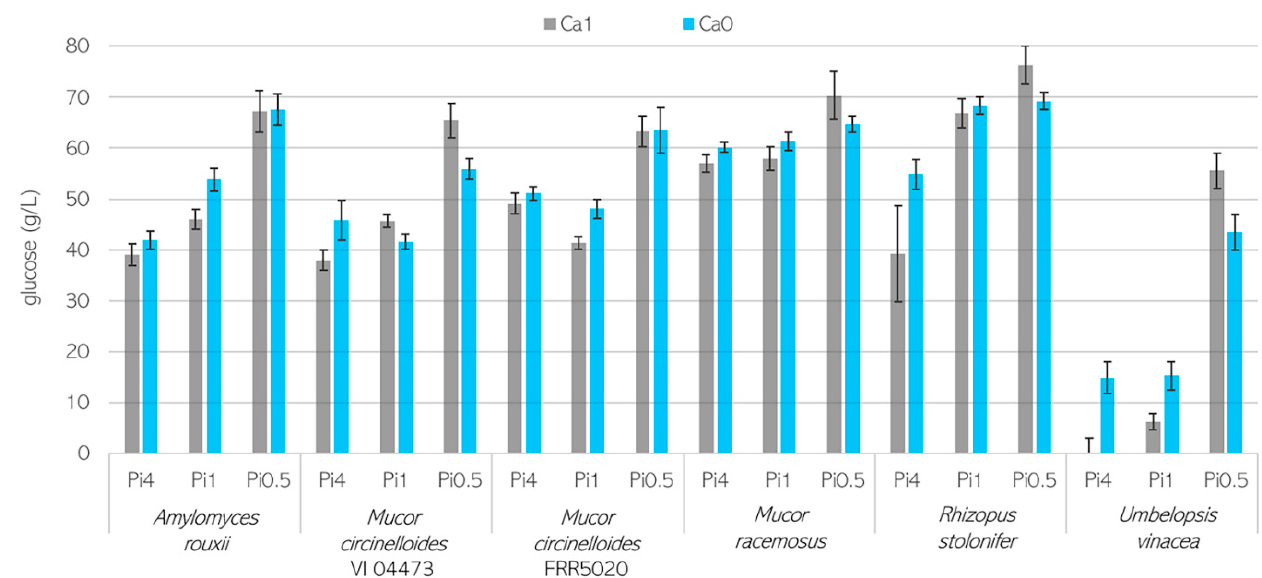
Figure 2. The residual glucose in g/L in the culture supernatants. The glucose concentration was estimated using a partial least square regression model based on the Fourier-transform infrared–attenuated total reflectance (FTIR-ATR) spectra of culture supernatants and reference glucose solutions. Initial glucose concentration was 80 g/L. Average values of four bio-replicates are presented, and error bars represent the standard deviation.